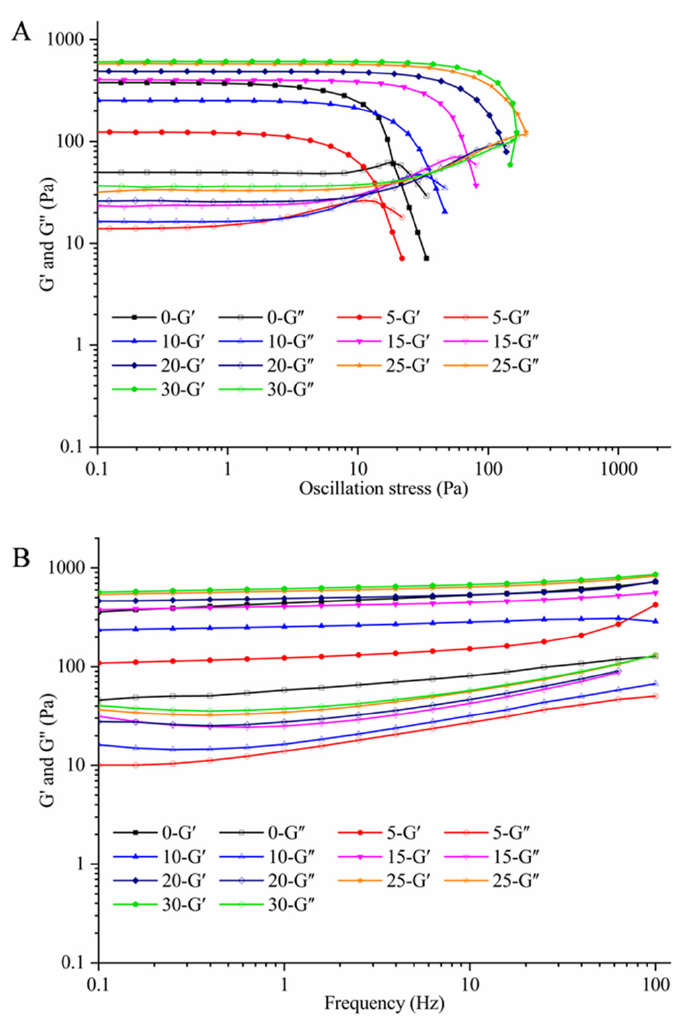
Figure 3. The storage modulus (G’, Pa) and loss modulus (G”, Pa) as a function of oscillation stress (Pa) with a constant frequency between 0.1 and 10 Hz ( A ) and as a function of frequency (Hz) with a constant strain of 1.00% ( B ) for HIPEs with different levels of Antarctic krill oil (AKO) (0, 5, 10, 15, 20, 25, and 30%, w/w ).